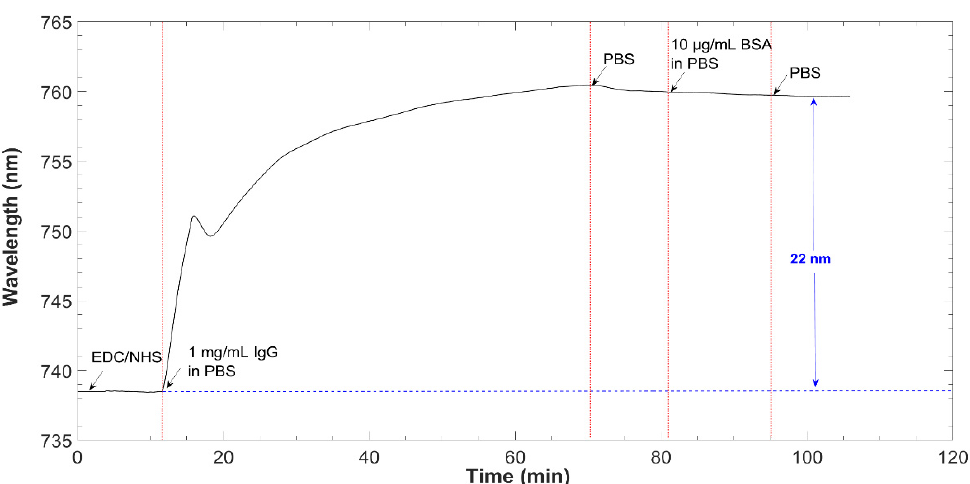
9 of 13 Figure 8. System response to the circulation of different refractive index glucose solutions: ( a ) sensorgram of different RI glucose solution detection, and ( b ) calibration curve of the sensor. 3.4. Anti-IgG Detection